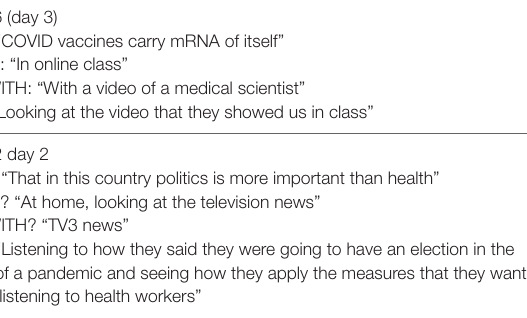
without listening to health